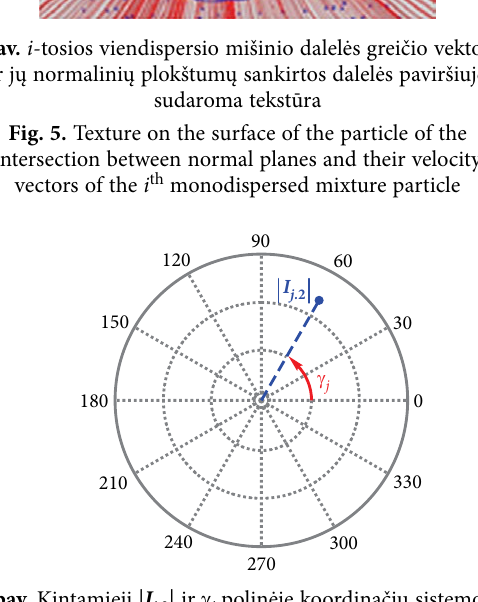
Fig. 6. Variables | I